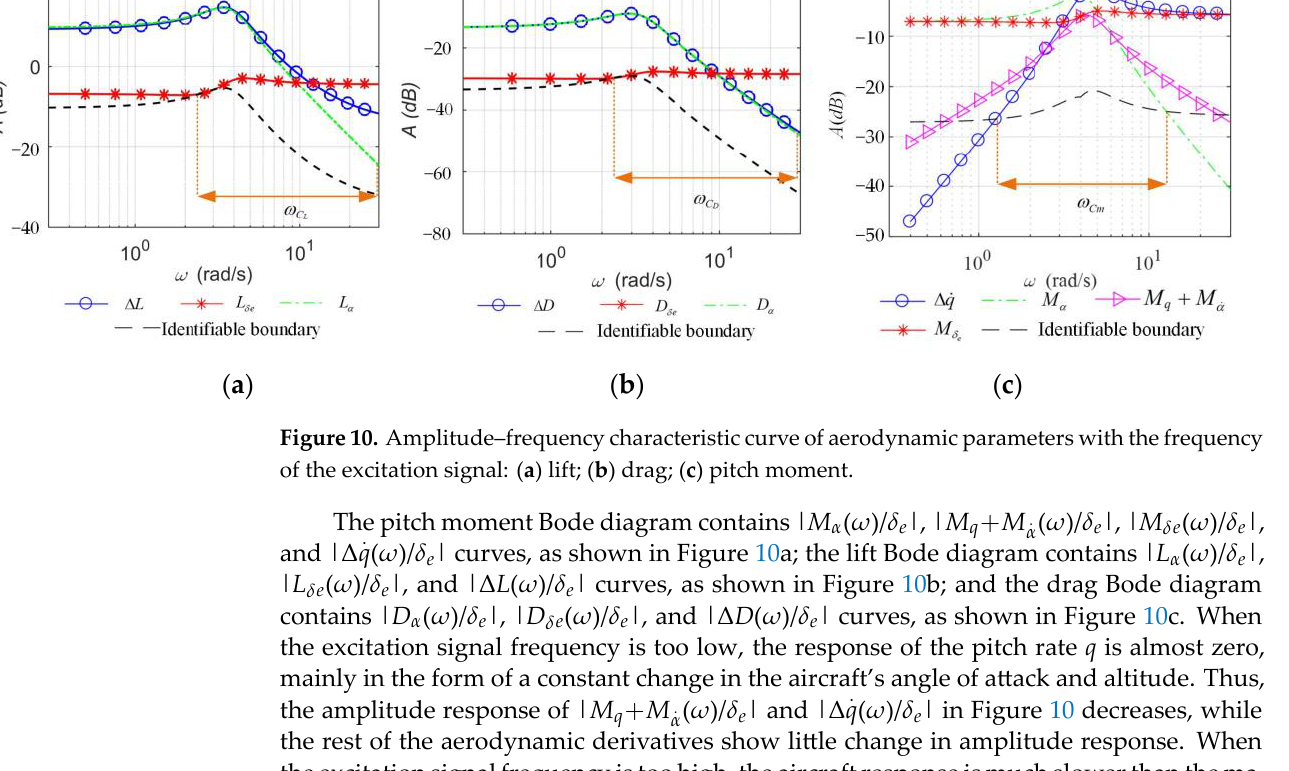
+M 𝛼̇ ( ω )/ δ e |, | M δ e ( ω )/ δ e |, q